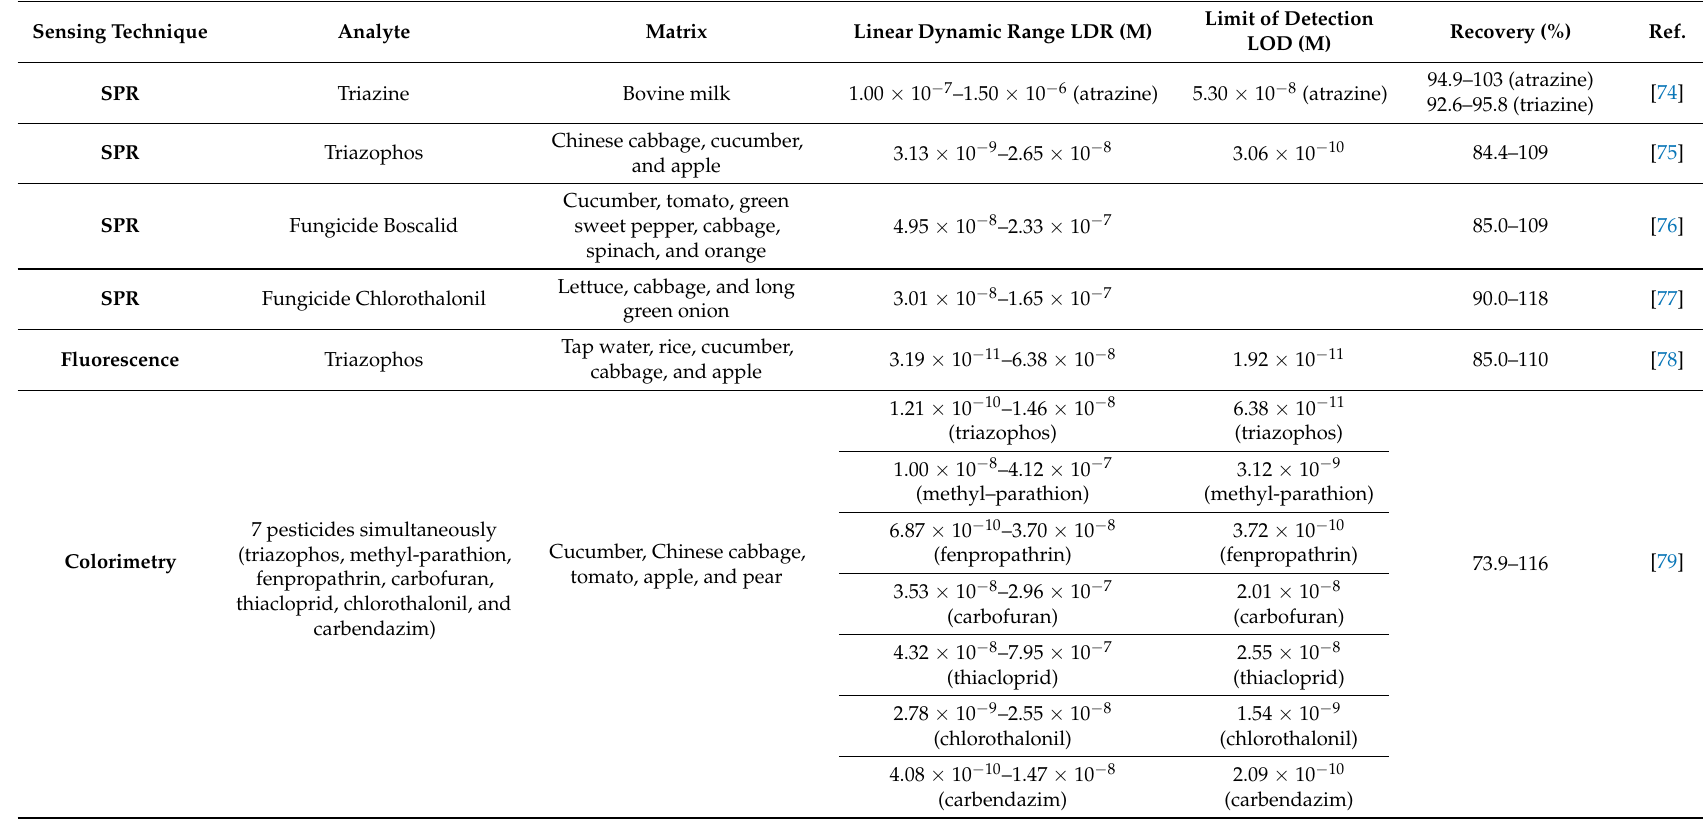
Table 2. Optical immunosensors for pesticides detection in food: main features and